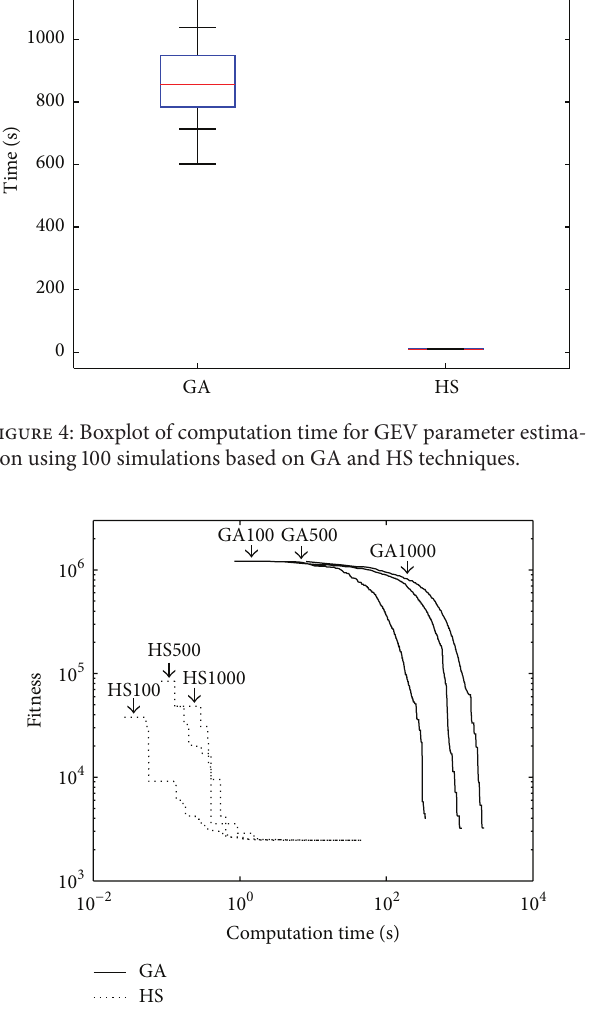
Figure 5: Comparison of computation time for GEV parameter estimation based on GA and HS methods.